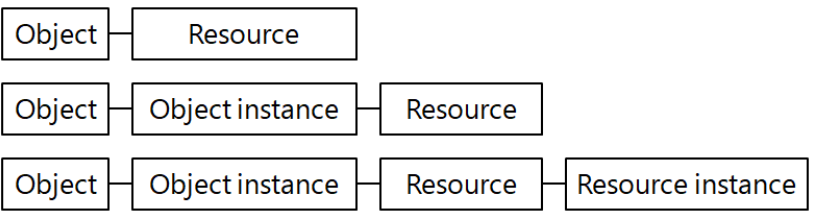
Figure 4. LwM2M URI structures.